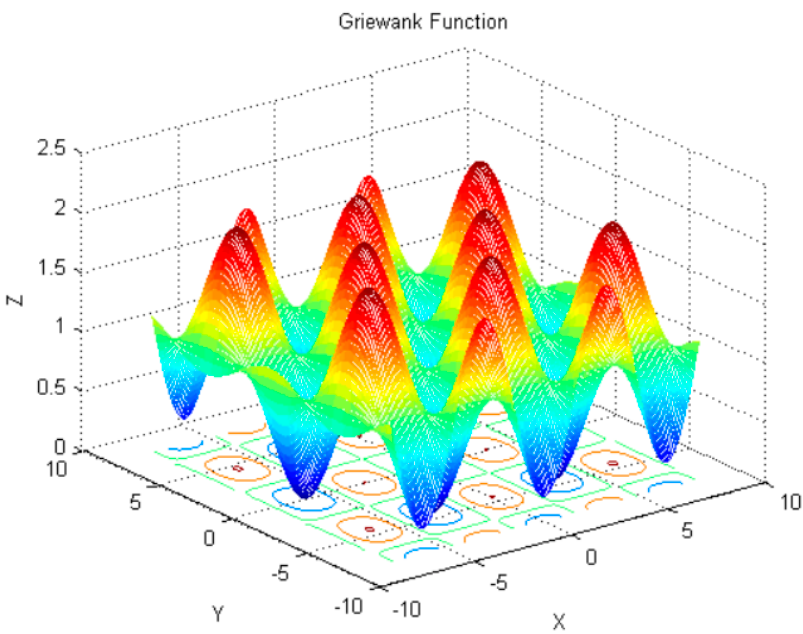
Figure 7. Three-dimensional graph of the Griewank function.